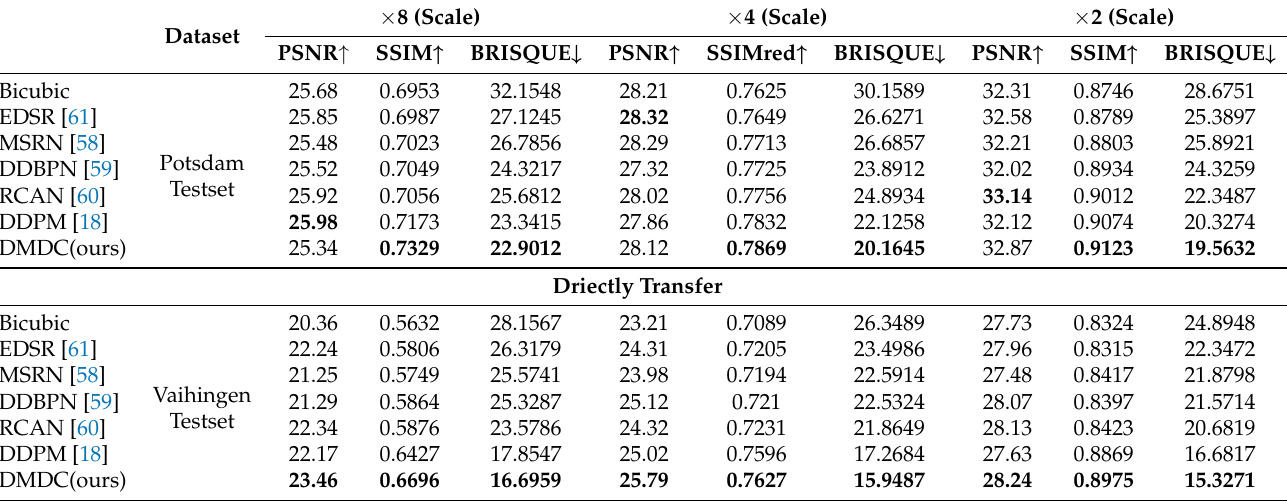
Table 1. Super-resolution results of × 8, × 4, × 2 magnification on ISPRS Potsdam and Vaihingen datasets. We report quantitative results for the SSIM and BRISQUE metrics. Note that we trained and tested on Potsdam. Then it is directly transferred to Vaihingen for testing, without any training or